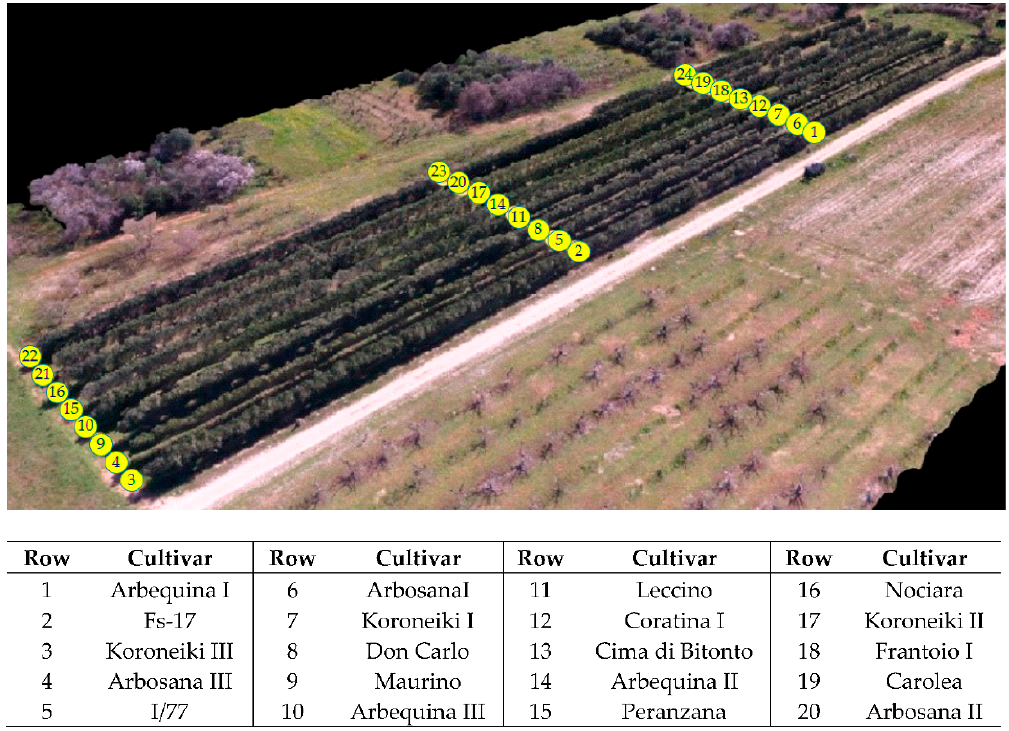
Figure 2. General location of the study area: ( a ) Apulia region, Italy; ( b ) overview of the image obtained by satellite of the area under study.